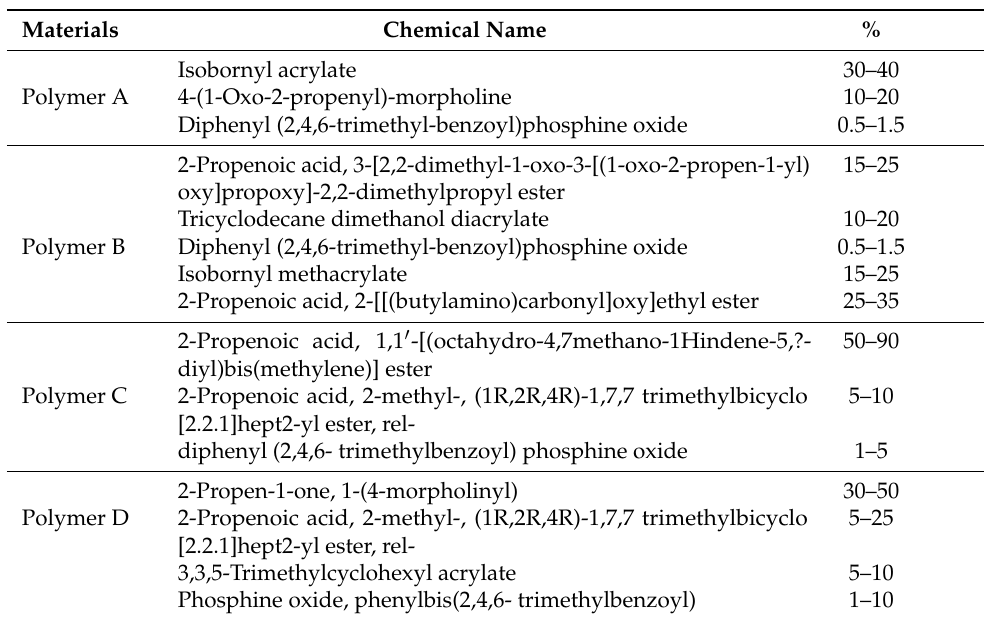
Figure 1. Specimens. Table 1. Chemical components of polymer materials